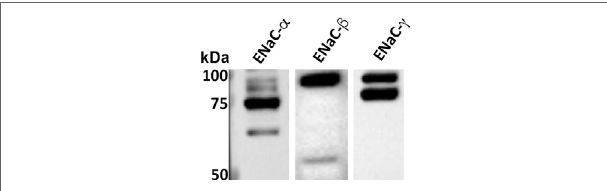
FigUre 1 | Representative western blot of basal expression of α , β , and γ epithelial sodium channel (ENaC) subunits in human lung microvascular endothelial cells. The immunoreactive bands at 95, 75, and 65 kDa are different forms of the subunits resulting from posttranslational modifications (e.g., glycosylation) and proteolytic processing. We previously confirmed the identity of similar bands excised from Coomassie stained gels after immunoprecipitation using the ENaC- α 59 and ENaC- β 60 antibodies and then performing LC/MS. We further corroborated the specificity of these antibodies by performing competition experiments using the recombinant fusion proteins that were used as the immunogens to generate the ENaC- α 59 and ENaC- β 60 antibodies (14). The characterization of the ENaC- γ 2102 antibody was described elsewhere (29). Although these ENaC